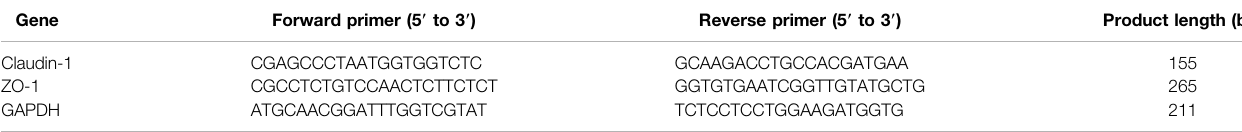
TABLE 2 | Primers used in quantitative real-time PCR reactions.